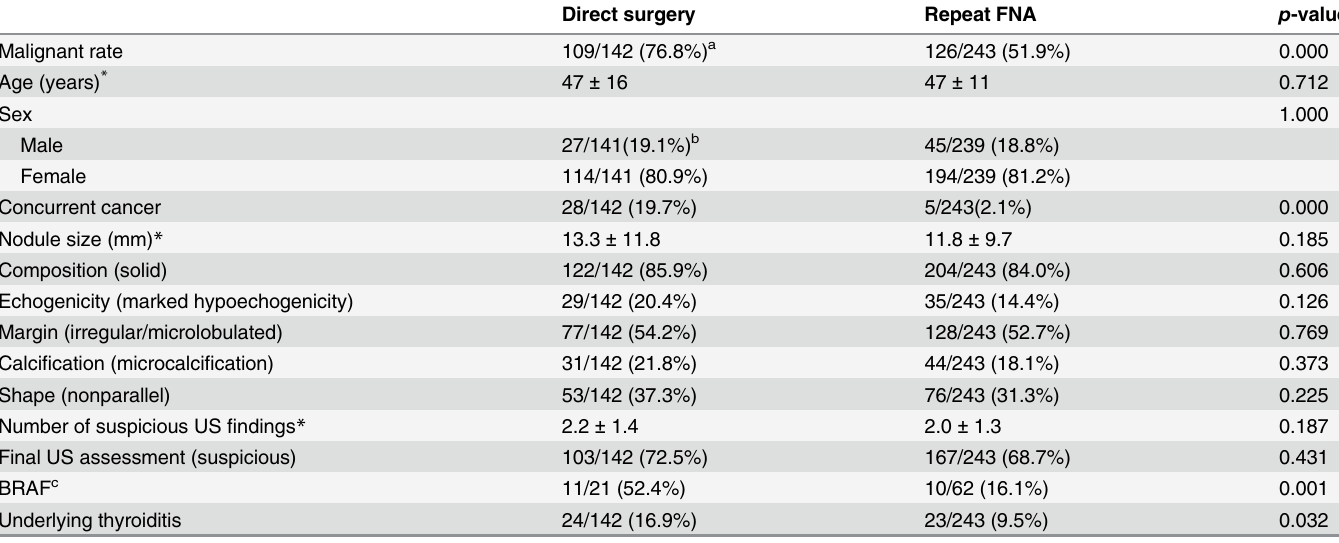
Table 1. Comparison of Malignancy Rates, Clinical and Ultrasonographic Features between Direct Surgery and Repeat FNA Groups.